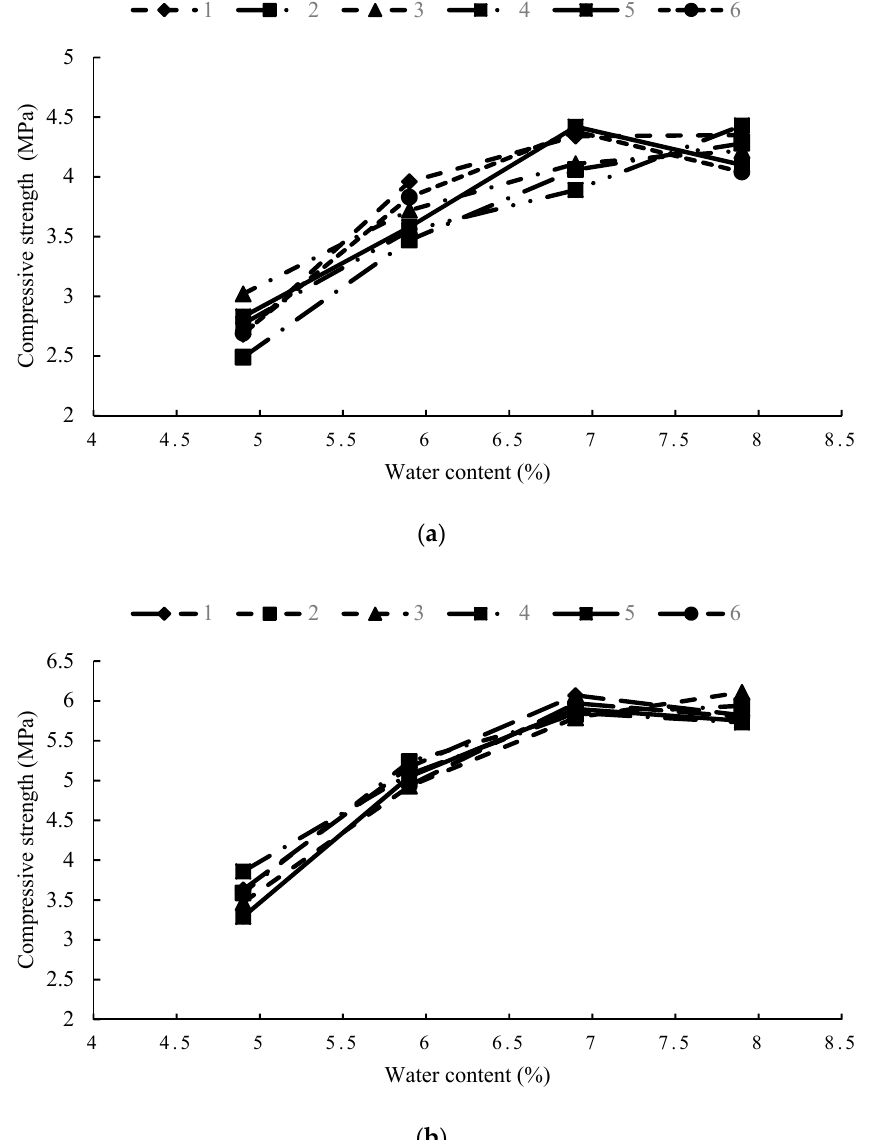
Figure 3. Compressive strength under different test procedures: ( a ) Relationship between water content and compressive strength after 7 days of curing; ( b ) relationship between water content and compressive strength after 28 days of curing.